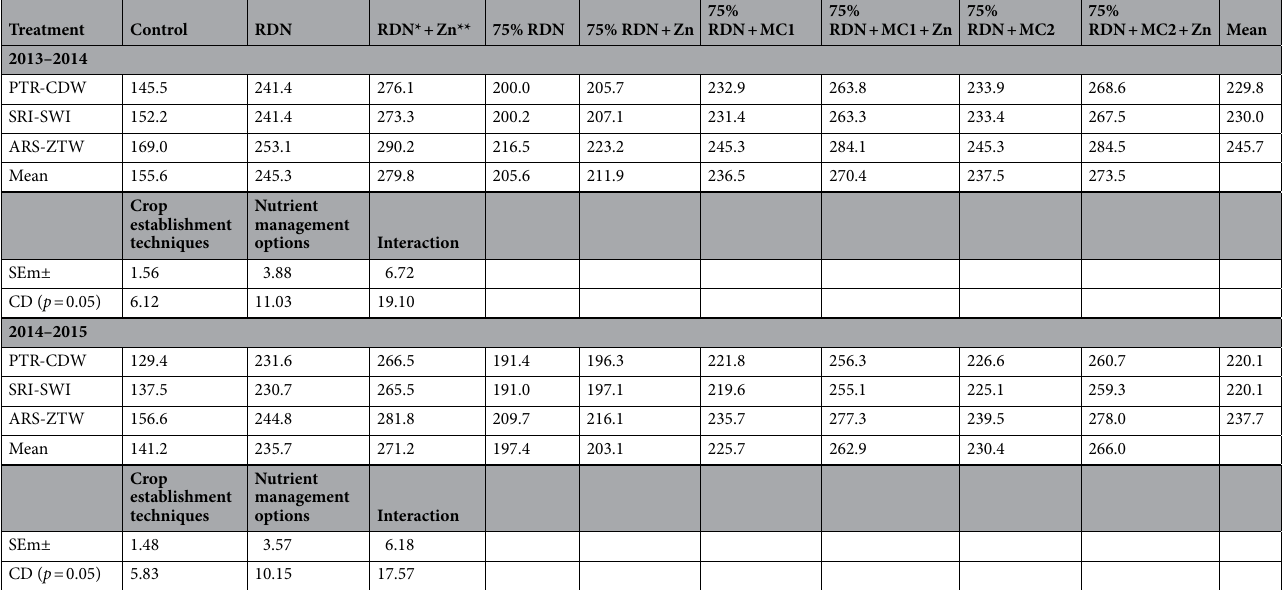
Table 2. Influence of crop establishment techniques and nutrient management options on nitrogen uptake (kg ha −1 ) in rice–wheat cropping system during 2013–2014 and 2014–2015. PTR , puddled transplanted rice; SRI , system of rice intensification; ARS , aerobic rice system; CDW , conventional drill-sown wheat; SWI , system of wheat intensification; ZTW , zero tillage wheat; RDN* , recommended dose of nutrients [120 kg nitrogen ha −1 and 25.8 kg phosphorus (P) ha −1 per crop]; Zn** , 5 kg Zn ha −1 through ZnSO 4 ·7H 2 O per crop; MC1 , Anabaena sp. (CR1) + Providencia sp. (PR3) consortium; MC2 , Anabaena – Pseudomonas biofilm; Potassium (K) was applied uniformly in all treatments @ 49.8 kg K ha –1 per crop; Interaction , significant in both cropping cycle.